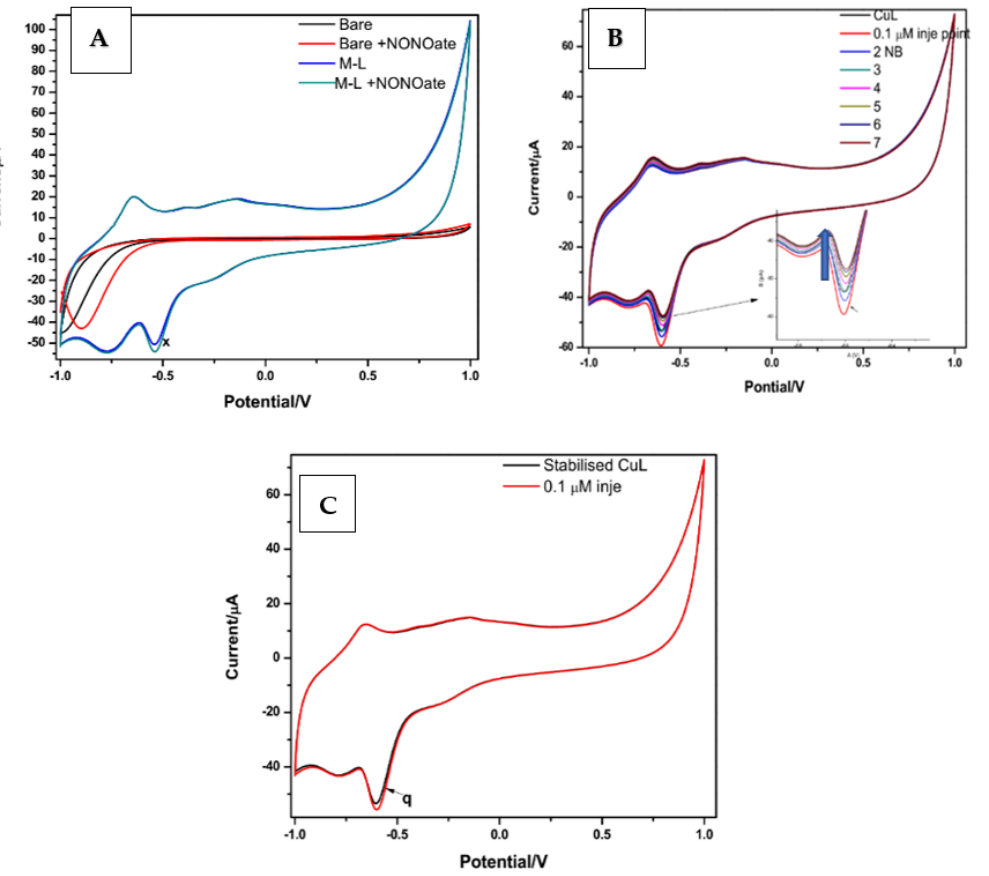
Figure 11. Cyclic voltammograms of an unmodified SPCE before NONOate injection (black), unmodified SPCE after NONOate injection (red), a modified electrode with the metal complex (blue) and a modified electrode in the presence of NONOate (green) and their current responses ( A ), current response after the 1st injection of a 0.1 µM of a DEA NONOate solution in a 0.1 M PBS ( B ), and the current response relative to the stabilised material and 1st cycle only ( C ); all performed in 0.1 M PBS (pH 7.2) in the potential range of − 1 to 1 and a scan rate of 50 mV/s under ambient